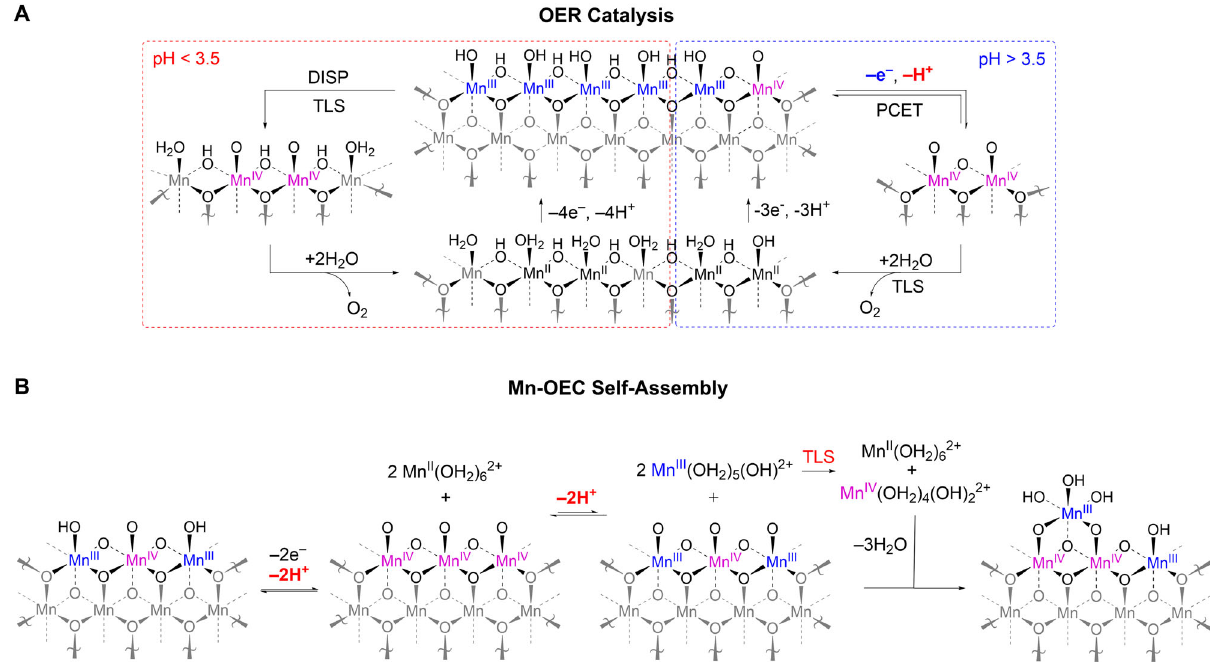
Fig. 4 Mn-OEC catalysis and self-assembly. A Proposed OER catalytic cycle for Mn-OECs, as determined from spectroscopic analysis and electrochemical kinetics studies at different pHs. B Proposed mechanism for the generation of Mn-OEC fi lms. The protons (H + ) that appear in the electrochemical rate laws for OER and catalyst deposition/regeneration are highlighted in red. Owing to the disproportionation reaction involving two manganese complexes, an inverse fourth-order proton dependence is observed, enabling self-healing to be preserved at pH > – 0.5. DISP and TLS denote disproportionation and turnover-limiting step,